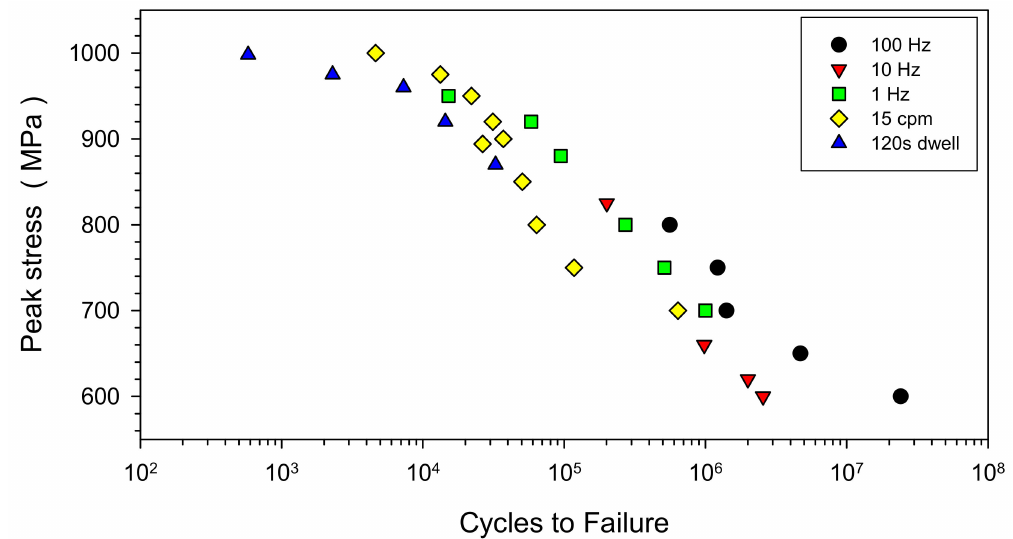
Figure 16. HCF, LCF and dwell fatigue data for Ti-834 bar stock material.